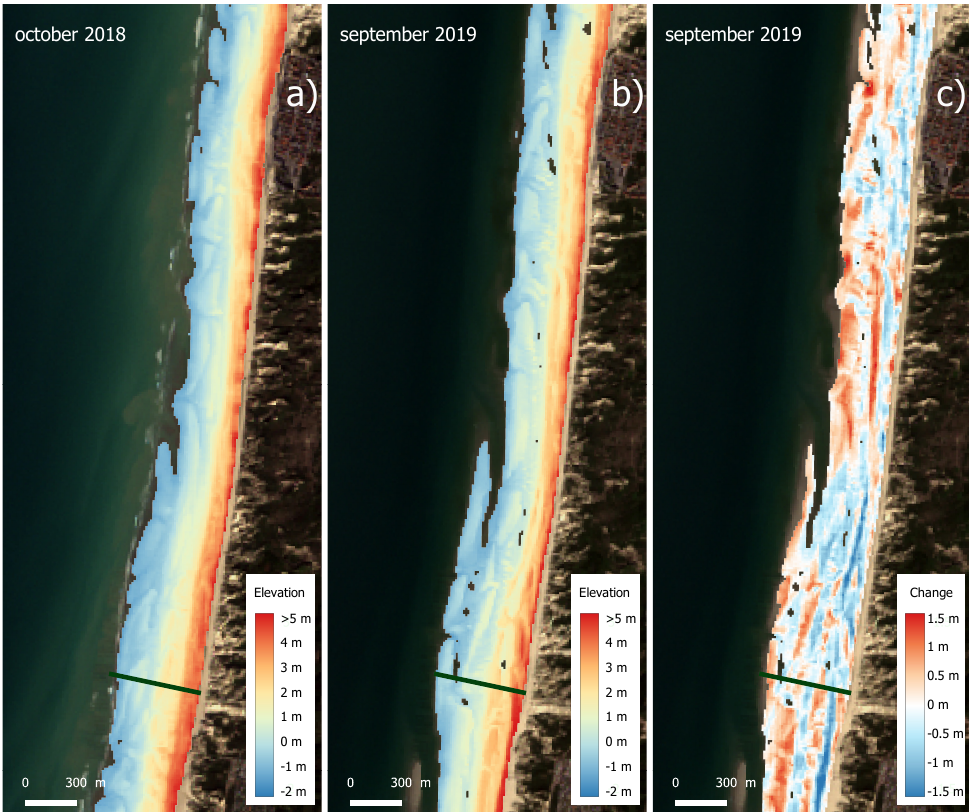
Figure 5. ( a ) DEM constructed from z model of October 2018 and ( b ) of September 2019. ( c ) Elevation changes DEM from 2018 to 2019. Background: Sentinel-2 RGB composite